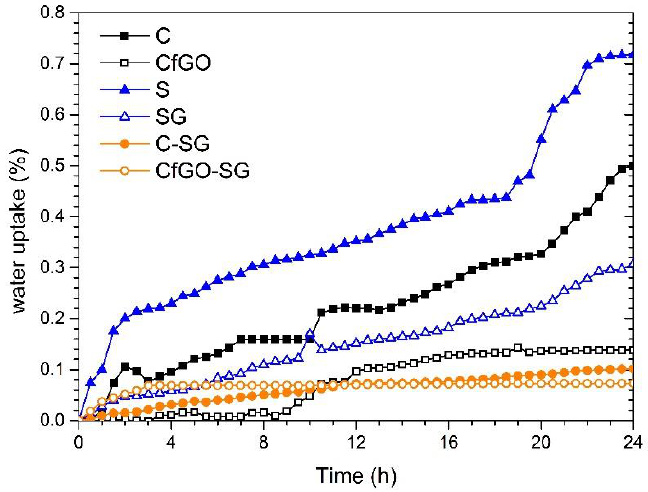
Figure 12. Water uptake during the first 24 h of immersion.